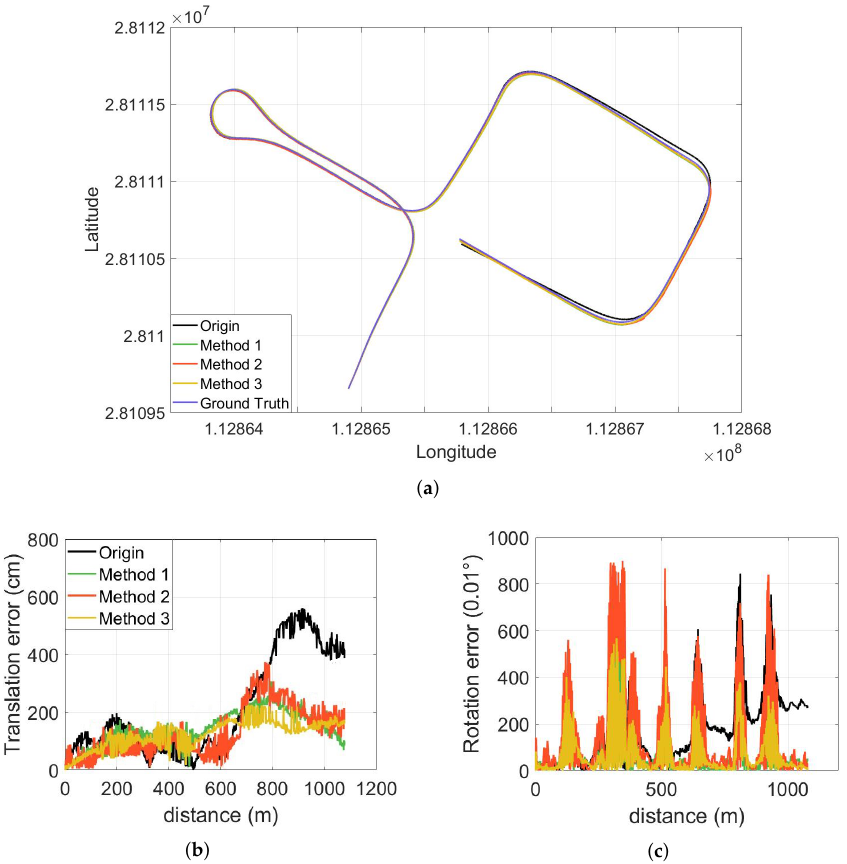
Figure 11. The localization results with/without rectification, where ( a ) compares the trajectories generated by the three rectification methods (Methods 1–3 represent rectification by the previous registration result, by registering two distorted point clouds and by the IMU data, respectively), the trajectory generated without rectification (Origin) and the ground truth; and ( b , c ) compare the translation error and rotation error among them, respectively. In this experiment, the UGV drives at a speed of around 60